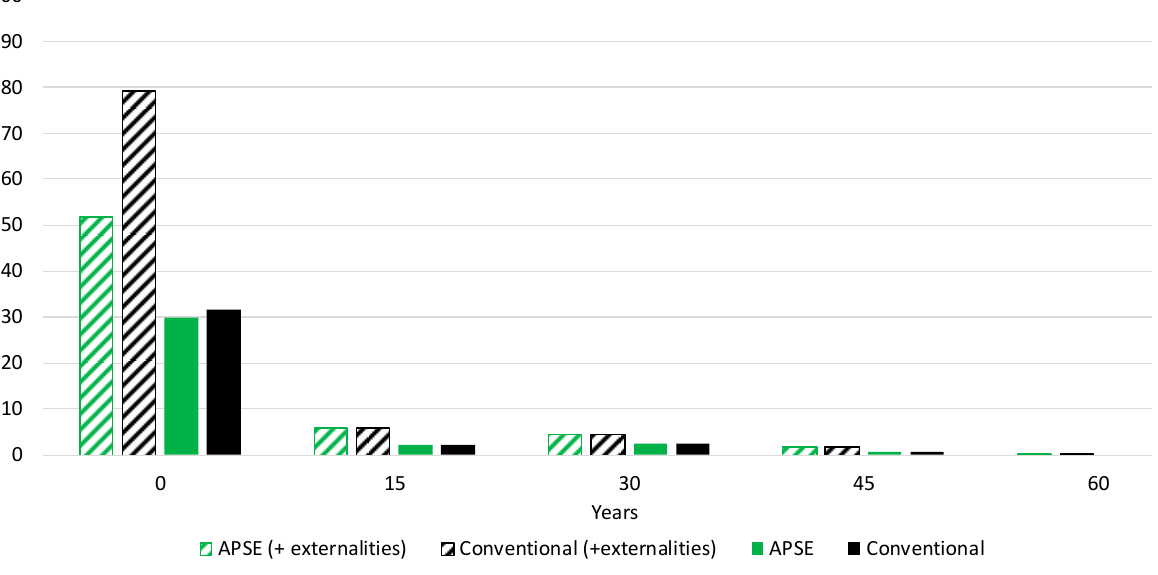
Figure 10. Total life cycle costs (in NPV) of pavement structures, considering costs of materials and costs of externalities.